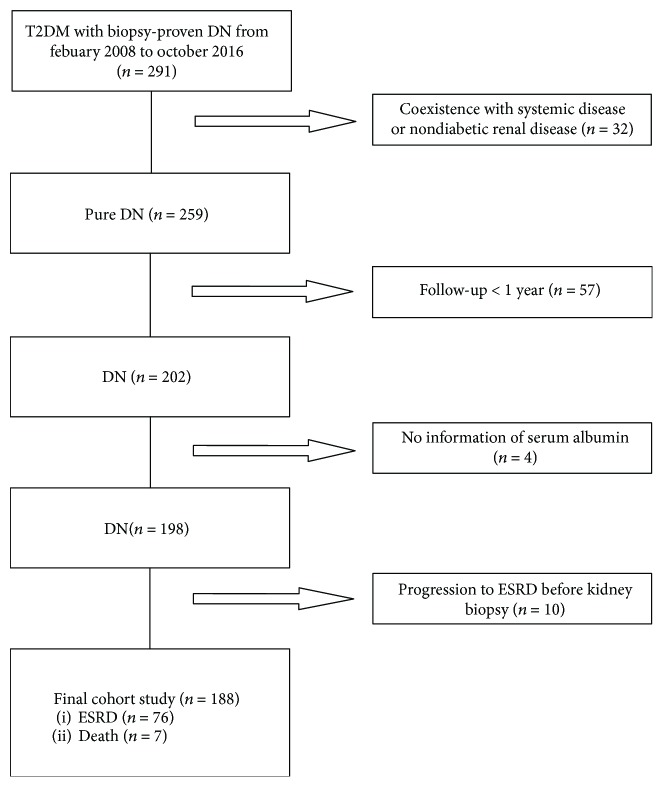
Flowchart of study participants.